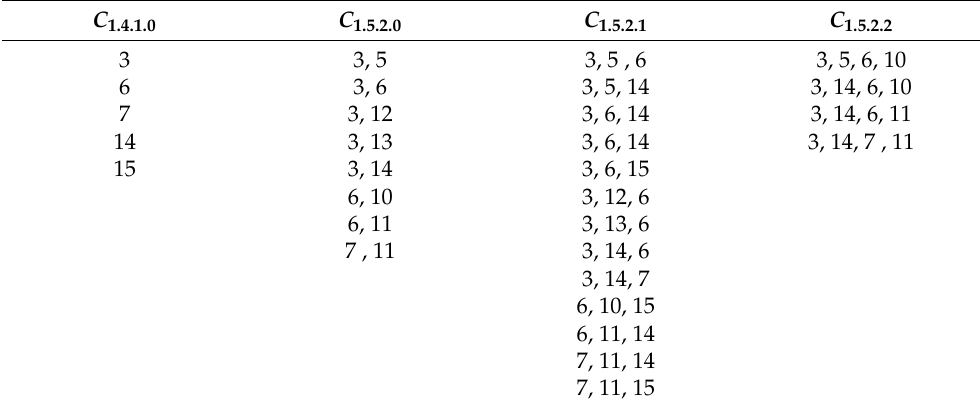
Table 1. Catalogs of the non-isomorphic FFSP designs in Example 1.